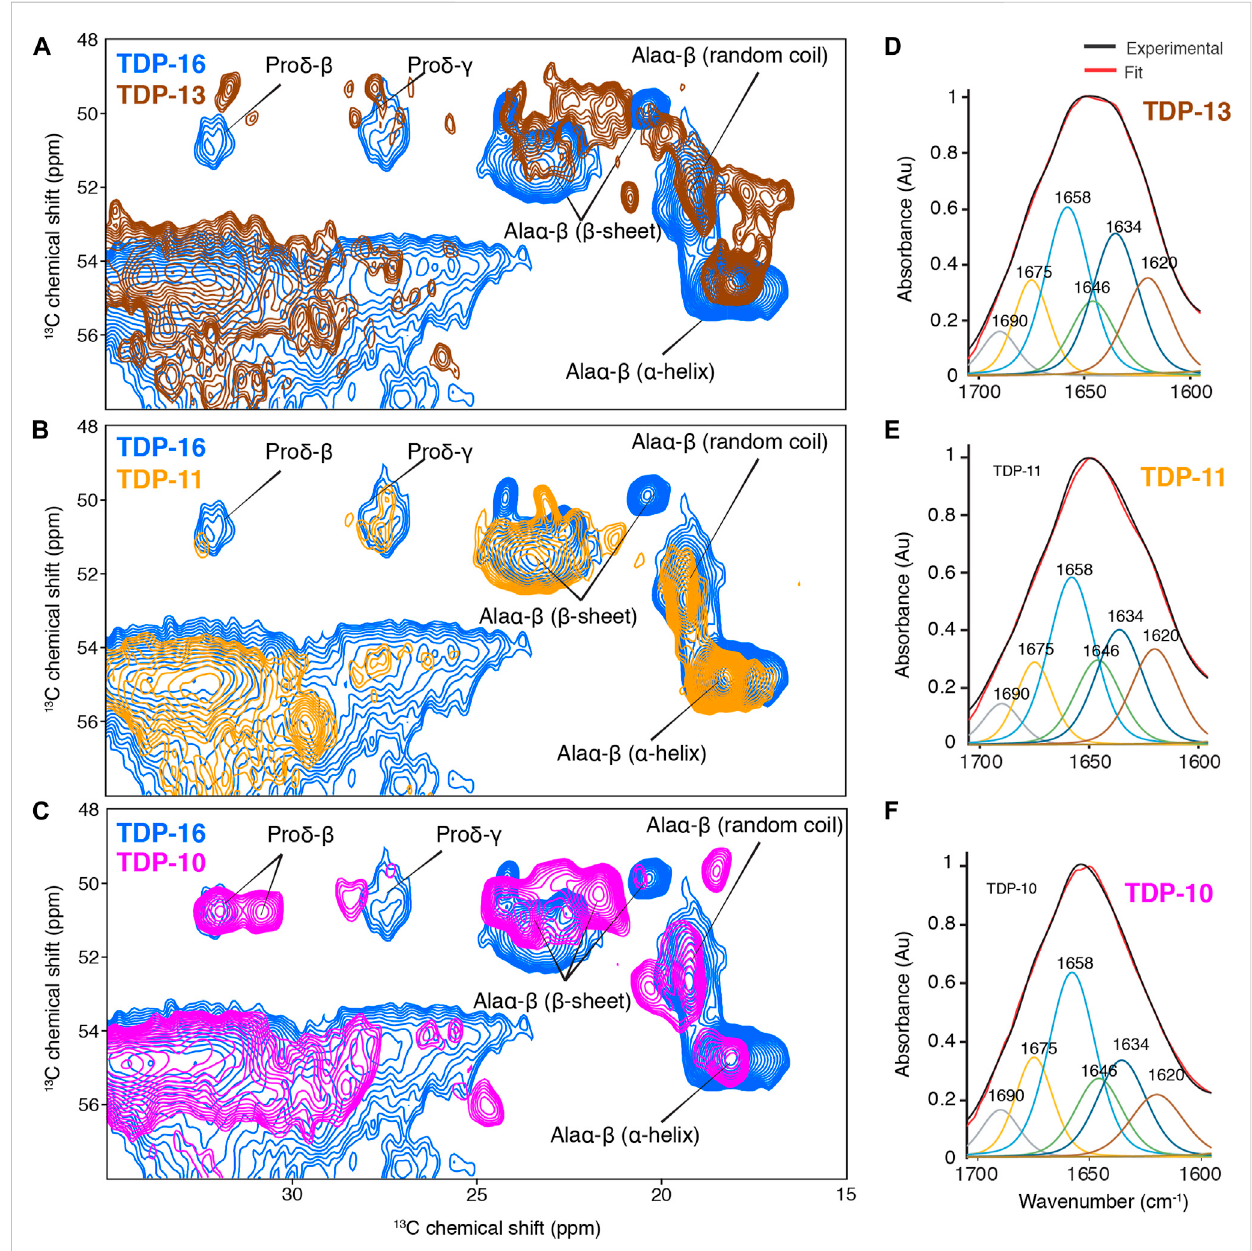
Comparison of the rigid cores of TDP-10, TDP11, and TDP-13 CTF aggregates by MAS NMR and FT-IR spectroscopy. (A – C) Spectral excerpts from the overlay of 2D 13 C – 13 C PDSD spectra (mixing time of 50 ms) of (A) TDP-13 (brown), (B) TDP-11 (orange), and (C) TDP-10 (pink) compared with TDP-16 (blue). Spectra were recorded at 600 MHz, 11 kHz MAS frequency at 278 (K) . Alanine C α – C β and proline C δ – C β correlations with chemical shift- dependent secondary structure are marked. FT-IR spectra of (D) TDP-13, (E) TDP-11, and (F) TDP-10 aggregates in the amide I and II range, displaying the experimental (black) and fi tted curve (red). The deconvolution of amide bands are shown on the FTIR spectra, displaying contribution of secondary structure elements, namely parallel and antiparallel β -sheet: 1,634 cm − 1 (dark blue), 1,620 cm − 1 (brown), and 1,690 cm − 1 (grey); α -helix: 1,658 cm − 1 (sky blue); turns: 1,675 cm − 1 (yellow), and random coil: 1,646 cm − 1